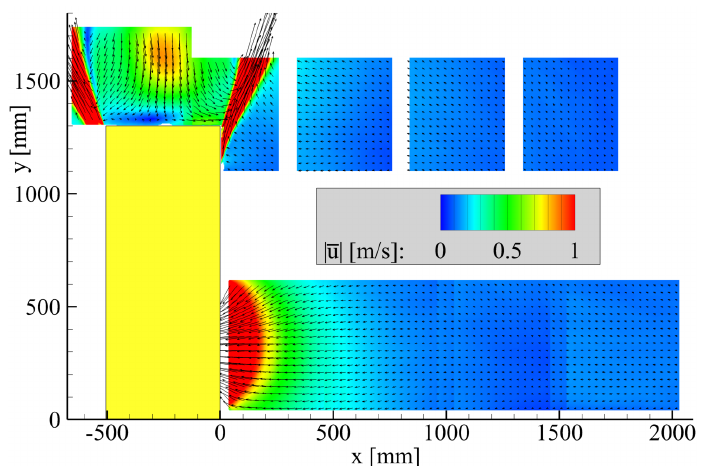
Figure 3. Magnitude of the mean in-plane velocity at an air cleaner flow rate of 1500 m 3 /h. The vectors visualize the direction and strength of the air flow. The color quantitatively illustrates the magnitude of the flow velocity.